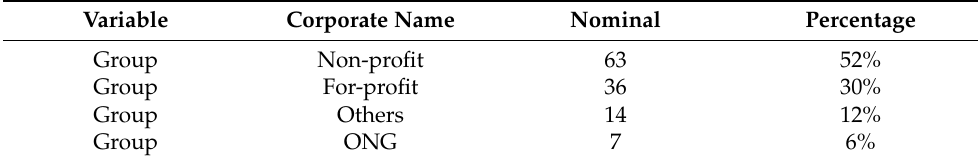
Table 11. Corporate Name.